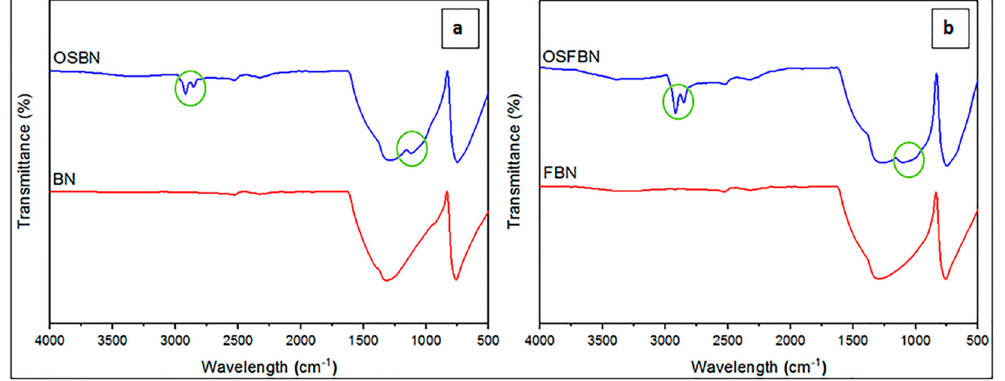
Figure 6. FTIR peaks of silanized ( a ) BN and ( b ) FBN.